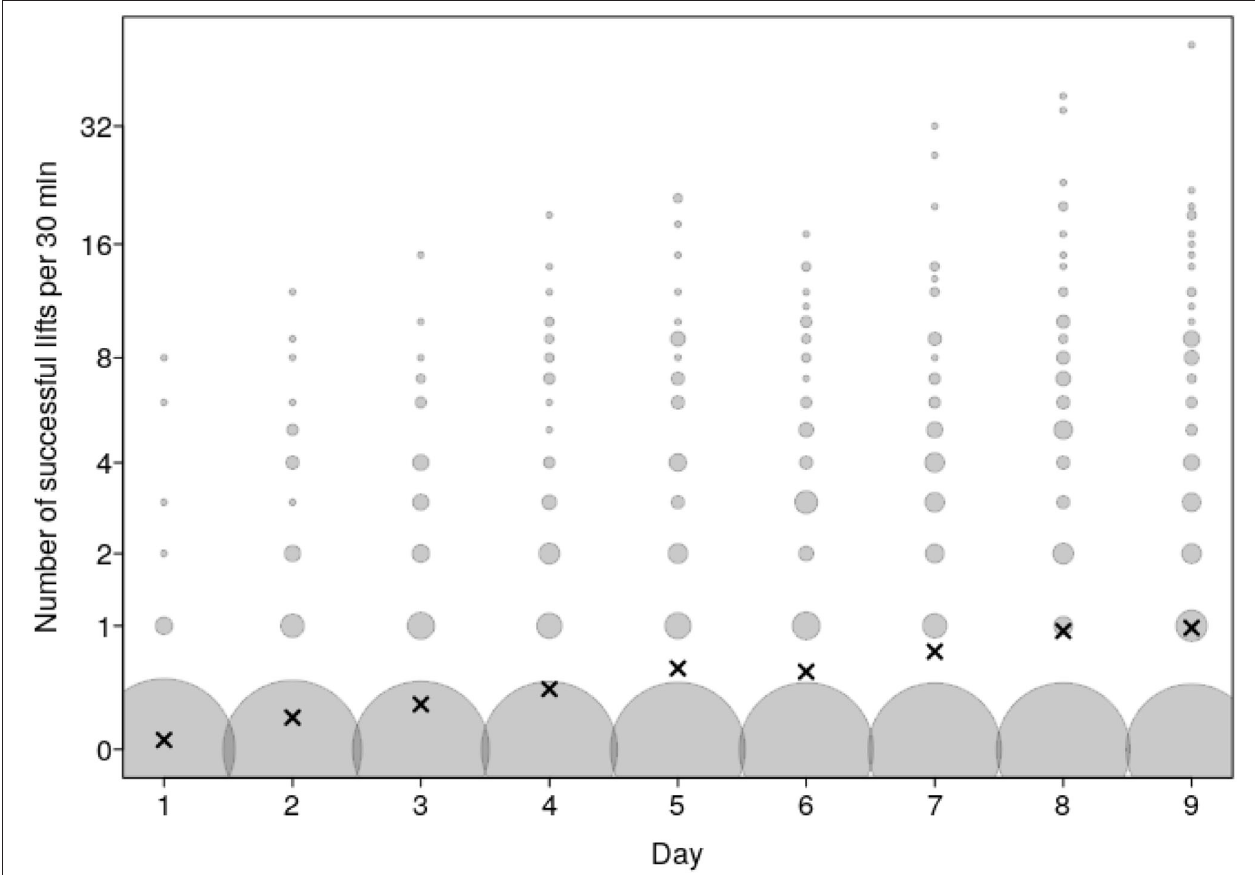
FIGURE 4 | Number of Successful lifts as a function of test day. Dots show the number of Successful lifts per test day and dyad whereby the area of the dots depicts the number of cases per combination of test day and number of Successful lifts (range: 1 to 468). The laying crosses depict the mean per day. A value of 0 was allocated to any of the potential dyadic combination of pigs in a group that did not perform a Successful lift on that day; hence the large number of 0